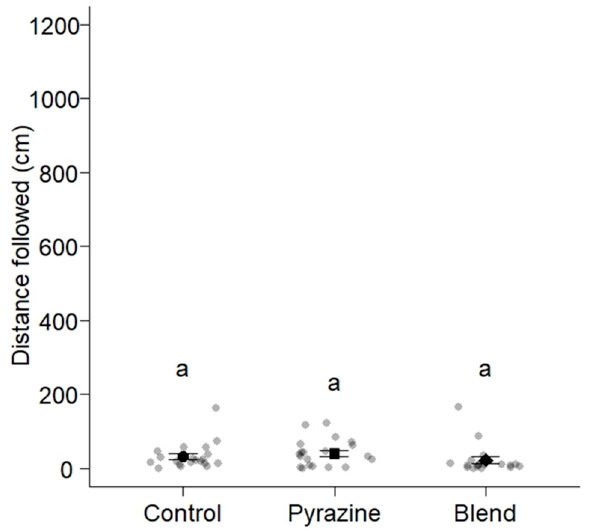
Figure 5. Distances worker ants of Myrmica rubra (n = 60) travelled following trails of synthetic 3-ethyl-2,5-dimethylpyrazine (the known trail pheromone of M. rubra [19]), a six-trail-pheromone blend (Table 1), and a solvent control applied to the circumference of a circular filter paper (diam: 90 mm) marked in 1-cm intervals (Figure 1). Grey and black symbols show the distance that each ant and 20 ants on average (mean ± whiskers) travelled, respectively, following trails. Means associated with different letters are statistically different (Tukey’s honest significant difference (HSD) test, p < 0.01).